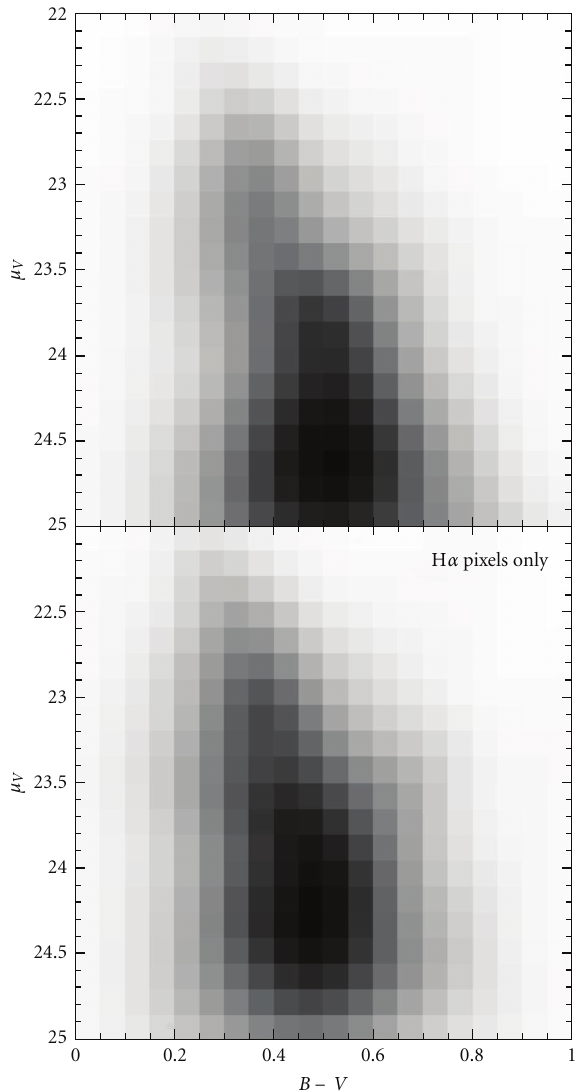
Figure 16: The pixel-to-pixel color-surface brightness map for all 58 galaxies in the sample. A total of 280,000 pixels are summed, then binned to produce the density plot of B − V color versus surface brightness on pixel scales. The top panel displays all pixels above 25Vmagarcsec − 2 , and the bottom panel displays only those pixels associated with H α emission.